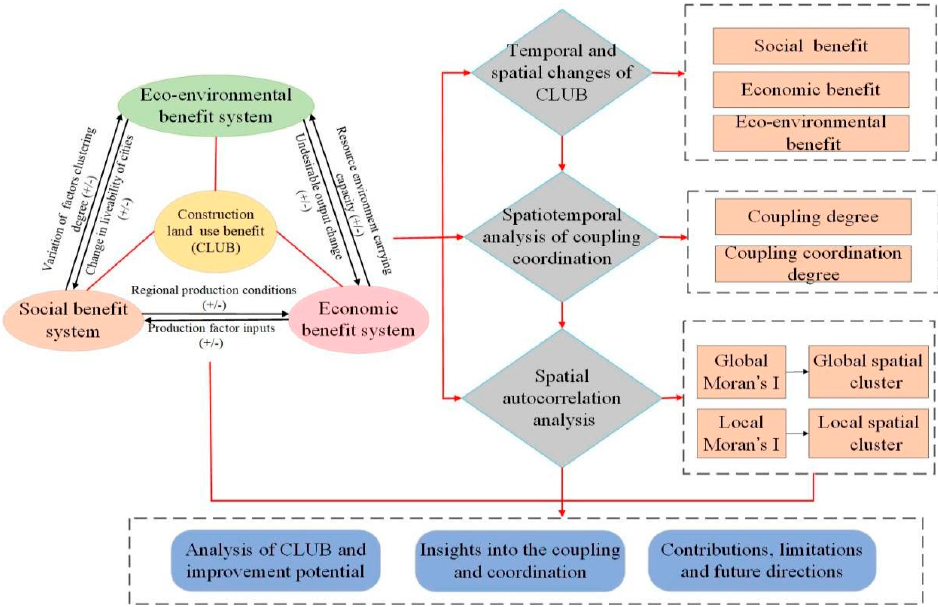
Figure 1. The coupling interaction relationship of the CLUB system and workflow of the study.